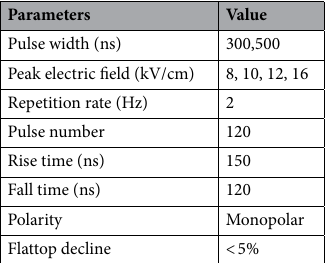
Table 4. The signal parameters of applied nsPEF in in-vitro experiments 25